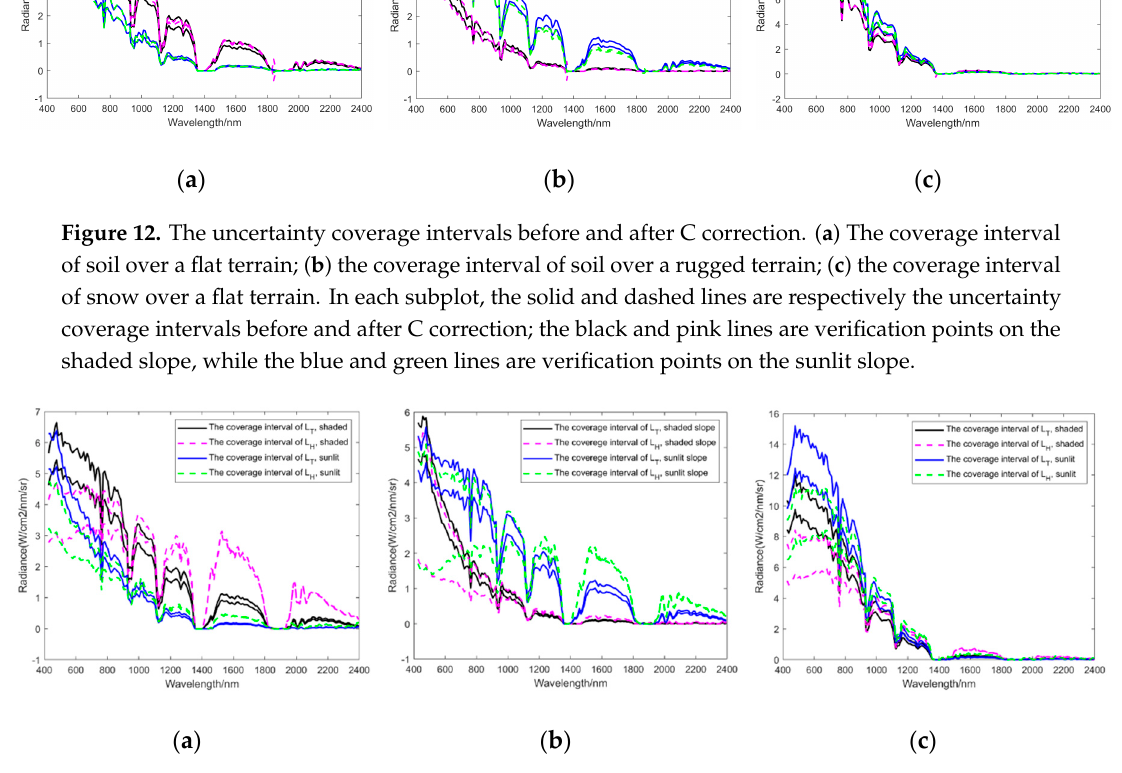
Figure 13. The uncertainty coverage intervals before and after Minnaert correction. ( a ) The coverage interval of soil over a flat terrain; ( b ) the coverage interval of soil over a rugged terrain; ( c ) the coverage interval of snow over a flat terrain. In each subplot, the solid and dashed lines are respectively the uncertainty coverage intervals before and after Minnaert correction; the black and pink lines are verification points on the shaded slope, while the blue and green lines are verification points on the sunlit slope.